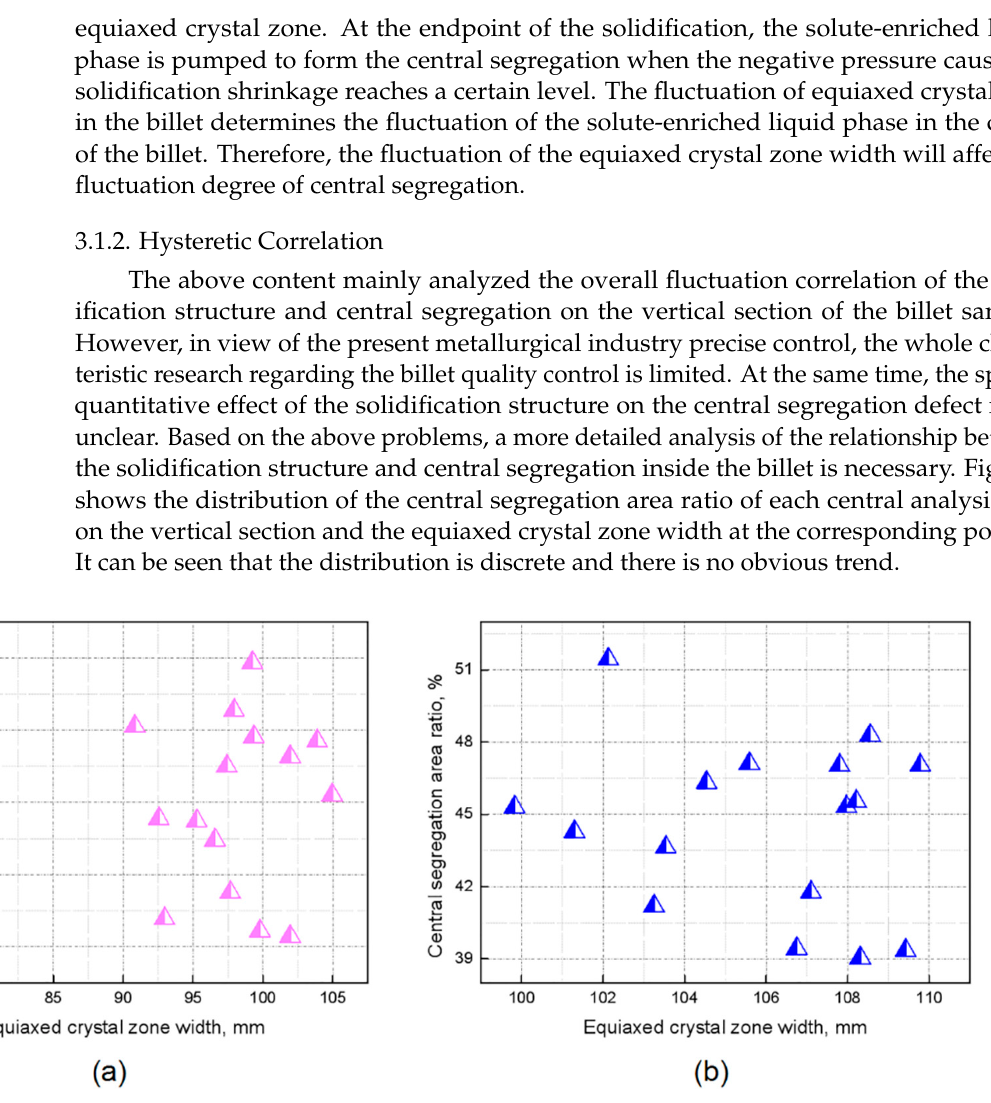
Figure 7. Hysteretic treatment of solidification structure and central segregation. The central anal- ysis area and the solidification structure correspond to each other is as shown in ( a ). When the central segregation in the analysis area is affected by the position where the hysteresis number is 1, the corresponding relationship is shown in ( b ). When the central segregation in the analysis area is affected by the position where the hysteresis number is 2, the corresponding relationship is shown in ( c ).